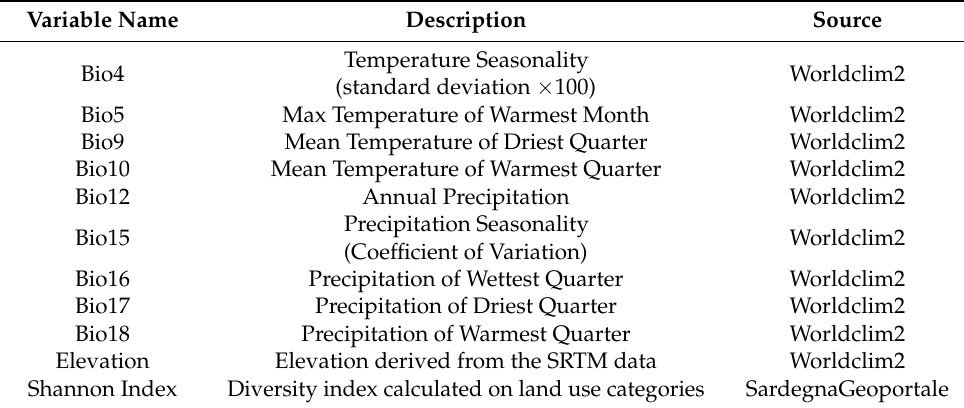
Table 1. Environmental variables considered in this